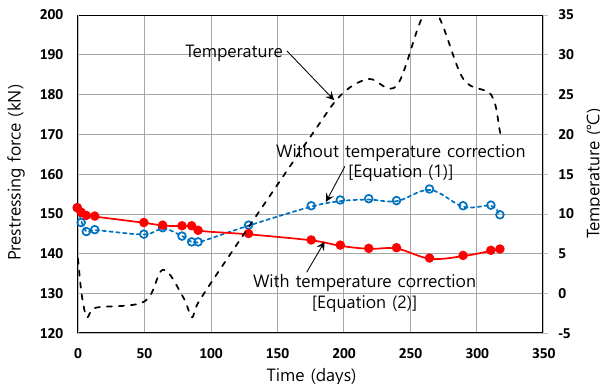
Figure 6. E ff ect of temperature correction on the prestressing force Figure 6. Effect of temperature correction on the prestressing force (PF). Figure 6. Effect of temperature correction on the prestressing force (PF).